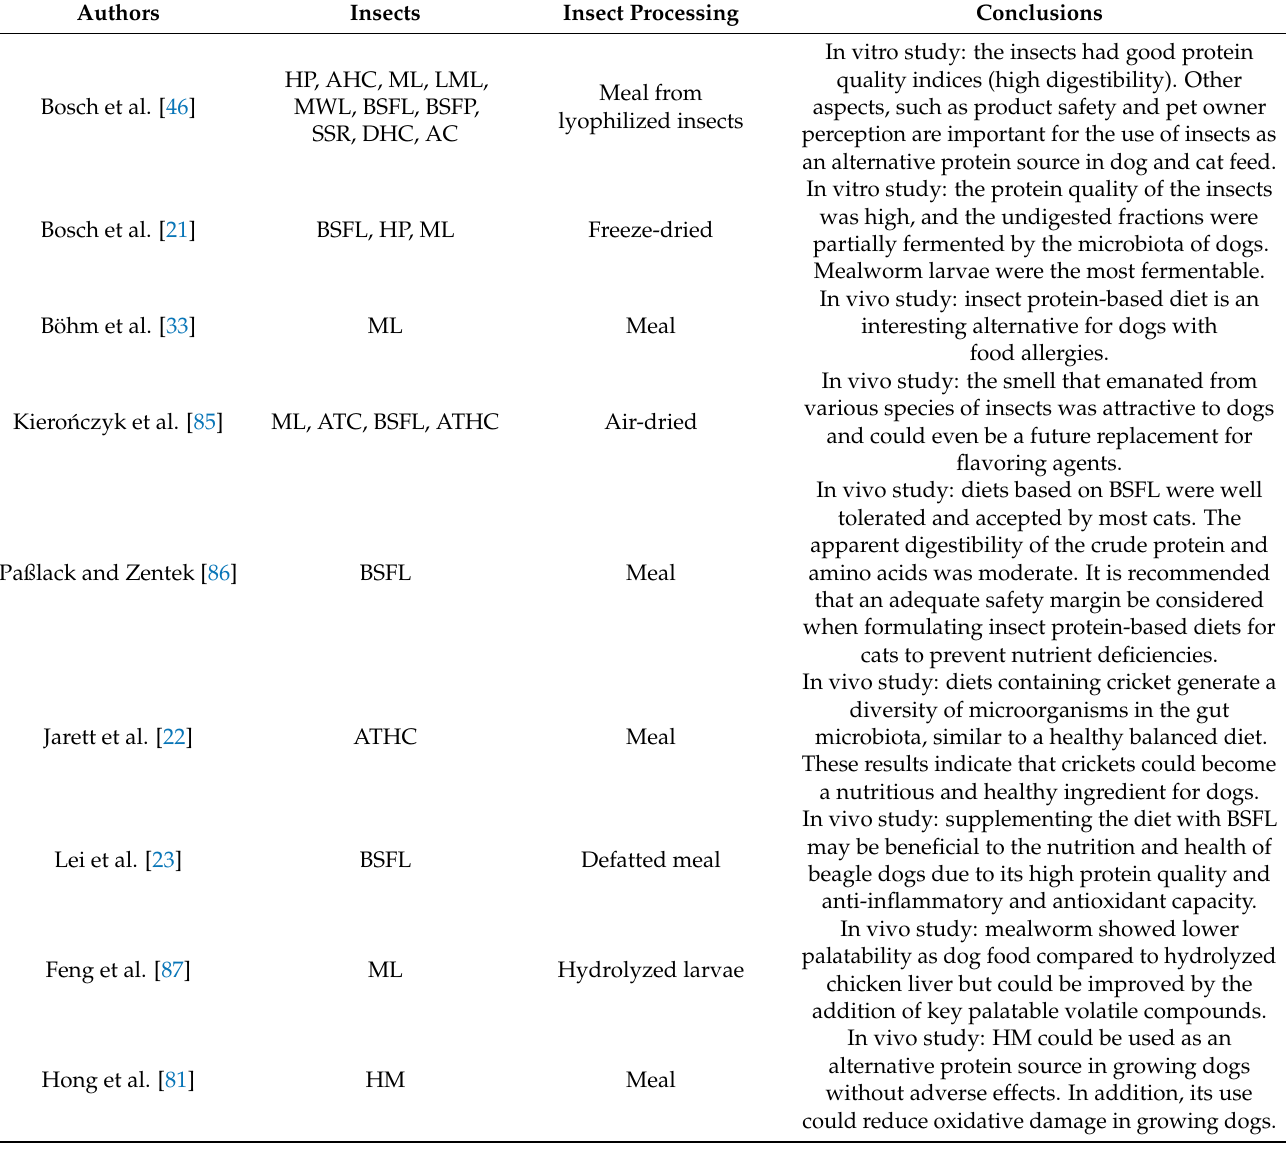
Table 3. Summary of in vivo and in vitro studies that have used insects in dog and cat